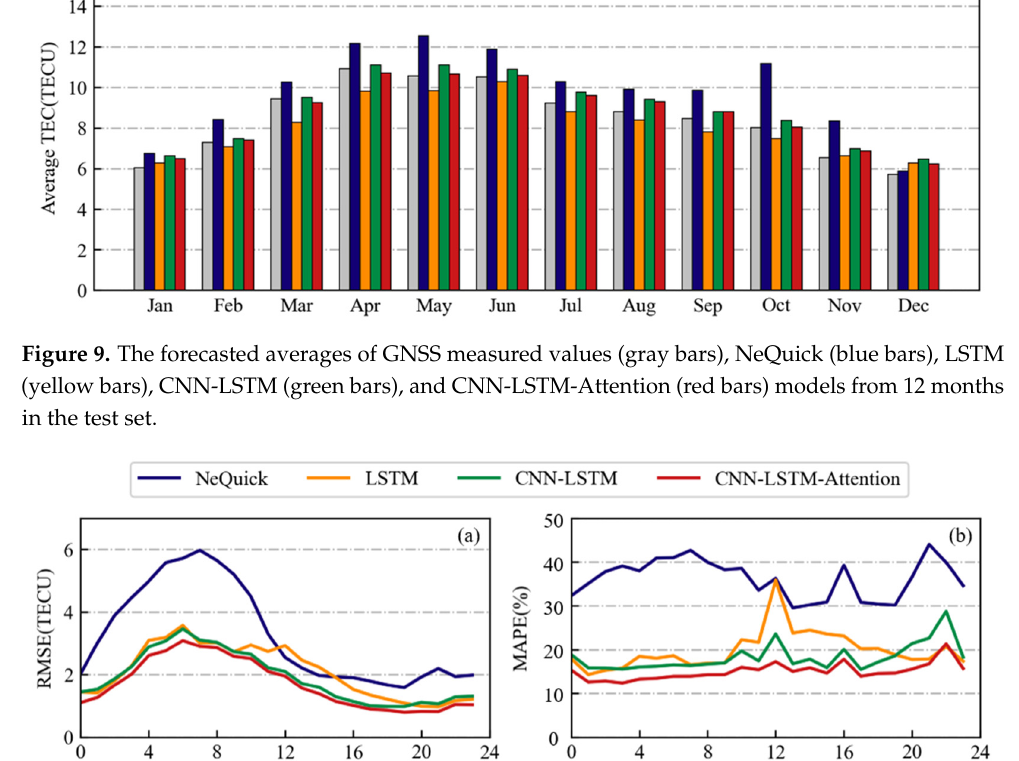
Figure 10. The forecasted ( a ) RMSE and ( b ) MAPE for each model, averaged across all of the stations for the year 2018, where the horizontal axis shows the start time for the forecast in UT.